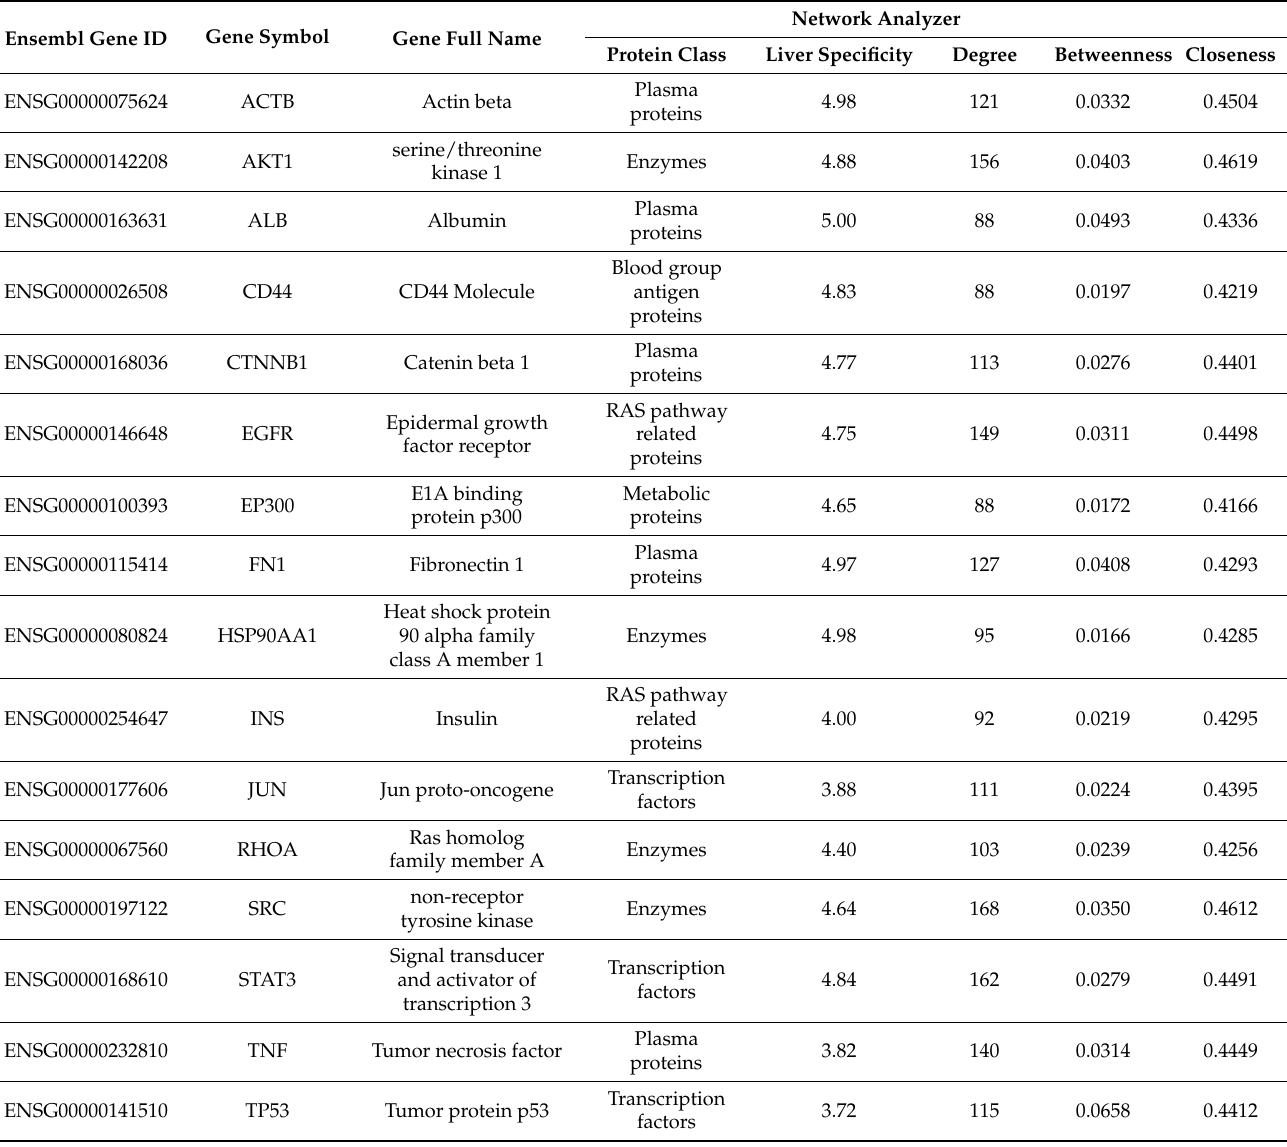
Table 1. The network analysis information of critical hub genes related to liver